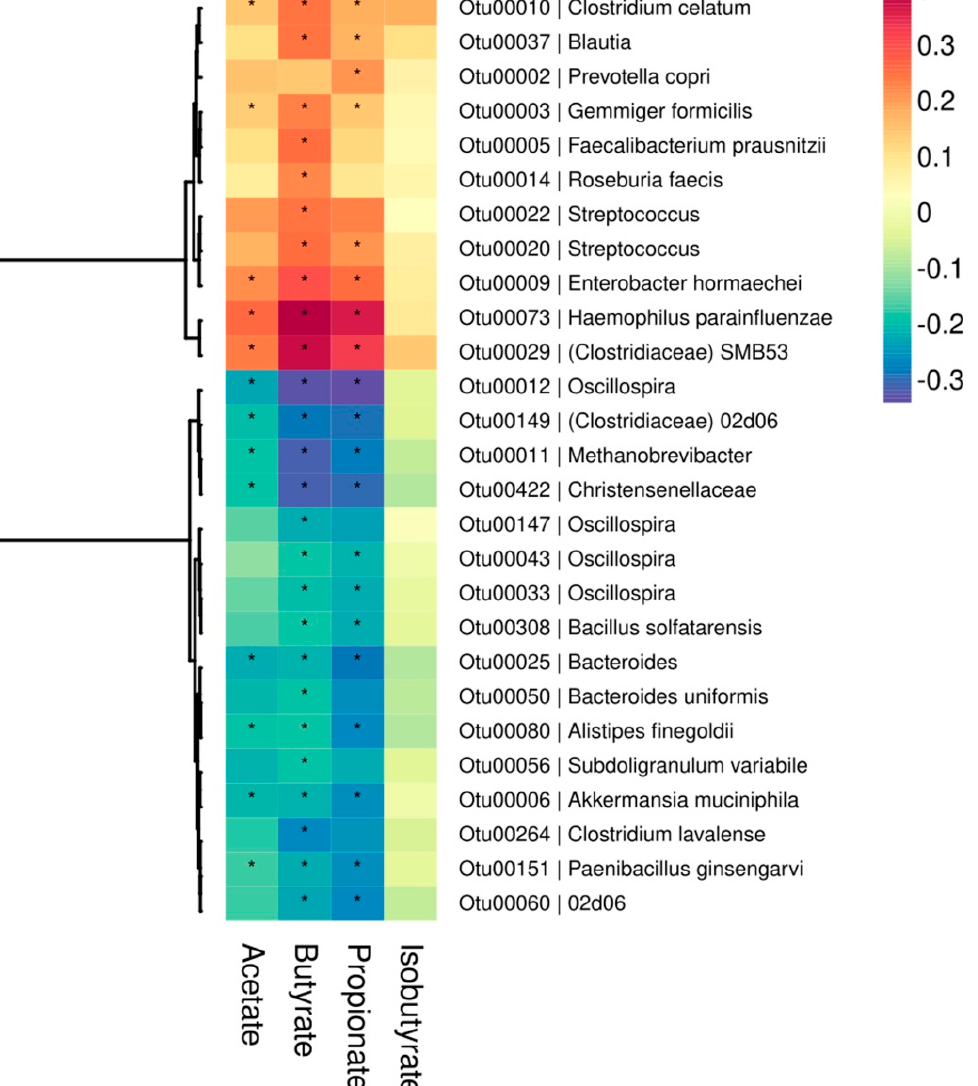
Figure 3. Heatmap showing the correlations between rarefied OTU abundances and multivariable-adjusted fecal SCFA concentrations. OTUs with moderate or strong association with at least one of the measured SCFAs are shown (|rho| > 0.2). The dendrogram to the left was obtained by hierarchical Ward-linkage clustering based on correlation coefficients of the relative abundances of the OTUs that had median abundances ≥ 0.001%. Models were adjusted for age, city of origin, caloric intake, physical activity, and fiber intake. The color scale indicates the Spearman’s correlation coefficients. FDR-adjusted p -values from quasi-Poisson generalized linear models are indicated (* = q < 0.10).